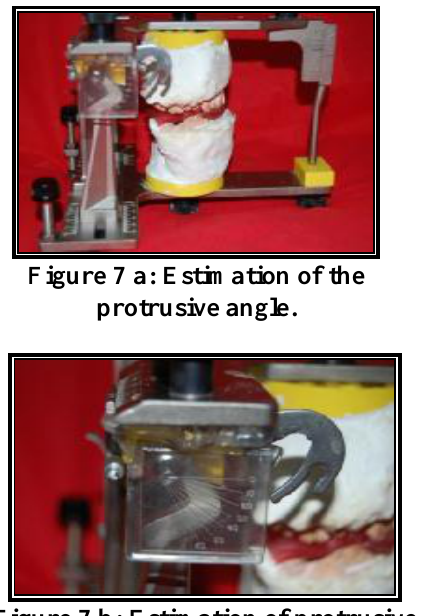
Figure 7 b: Estimation of protrusive